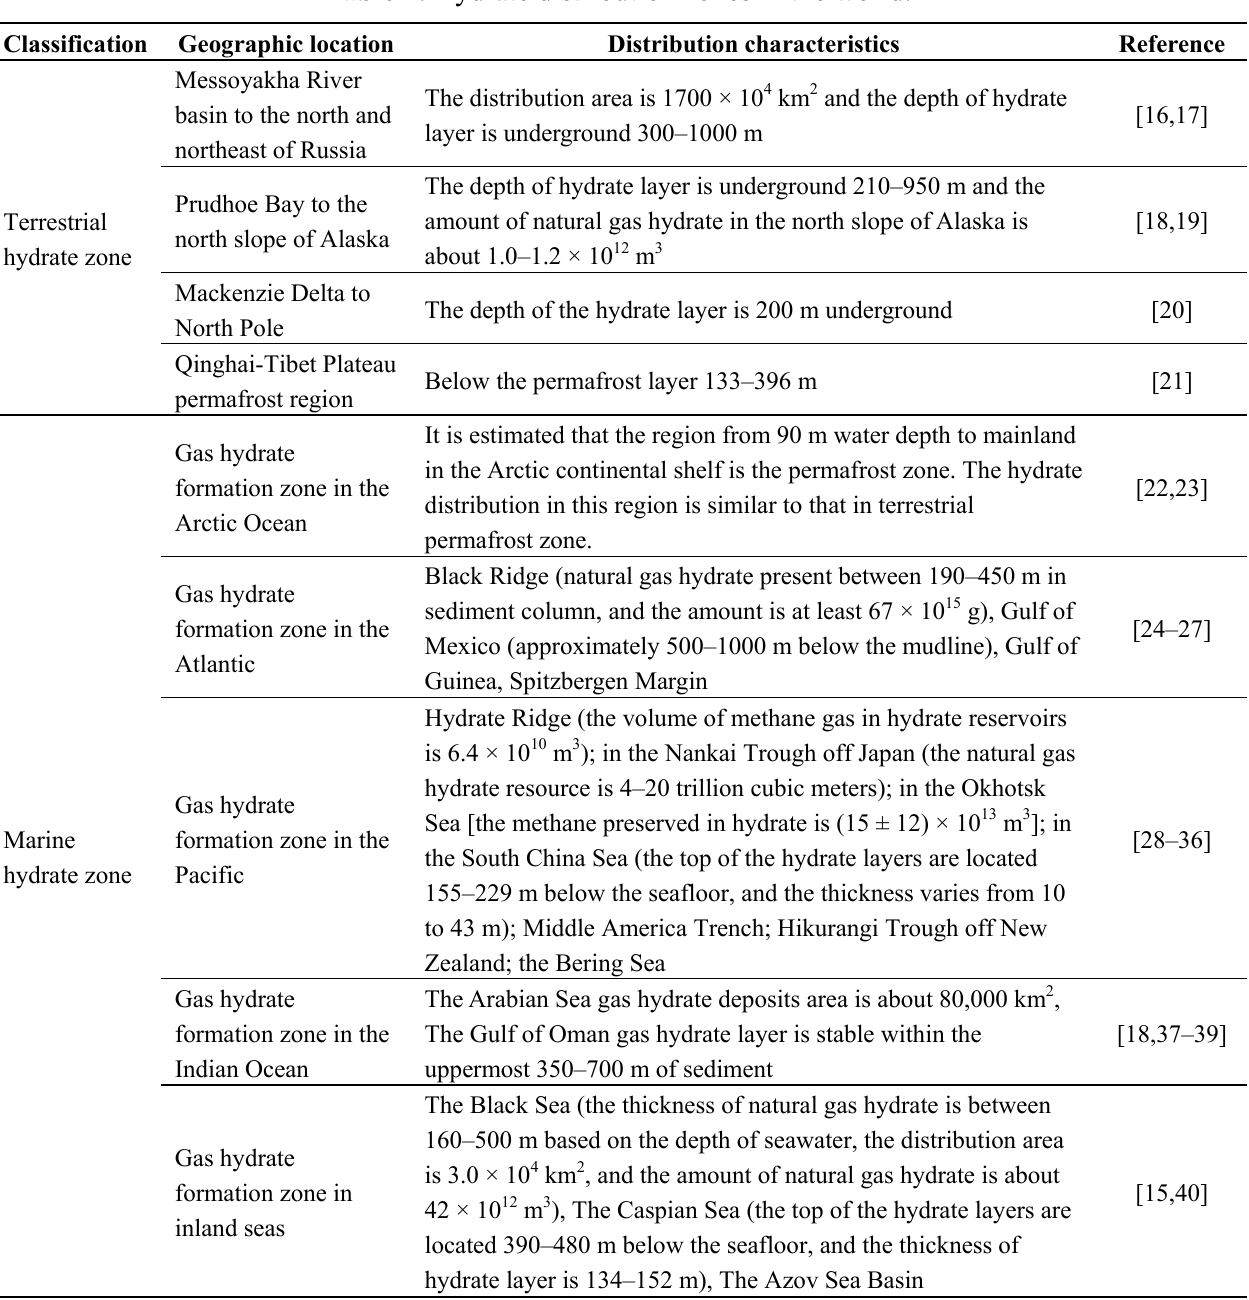
Table 1. Hydrate distribution zones in the